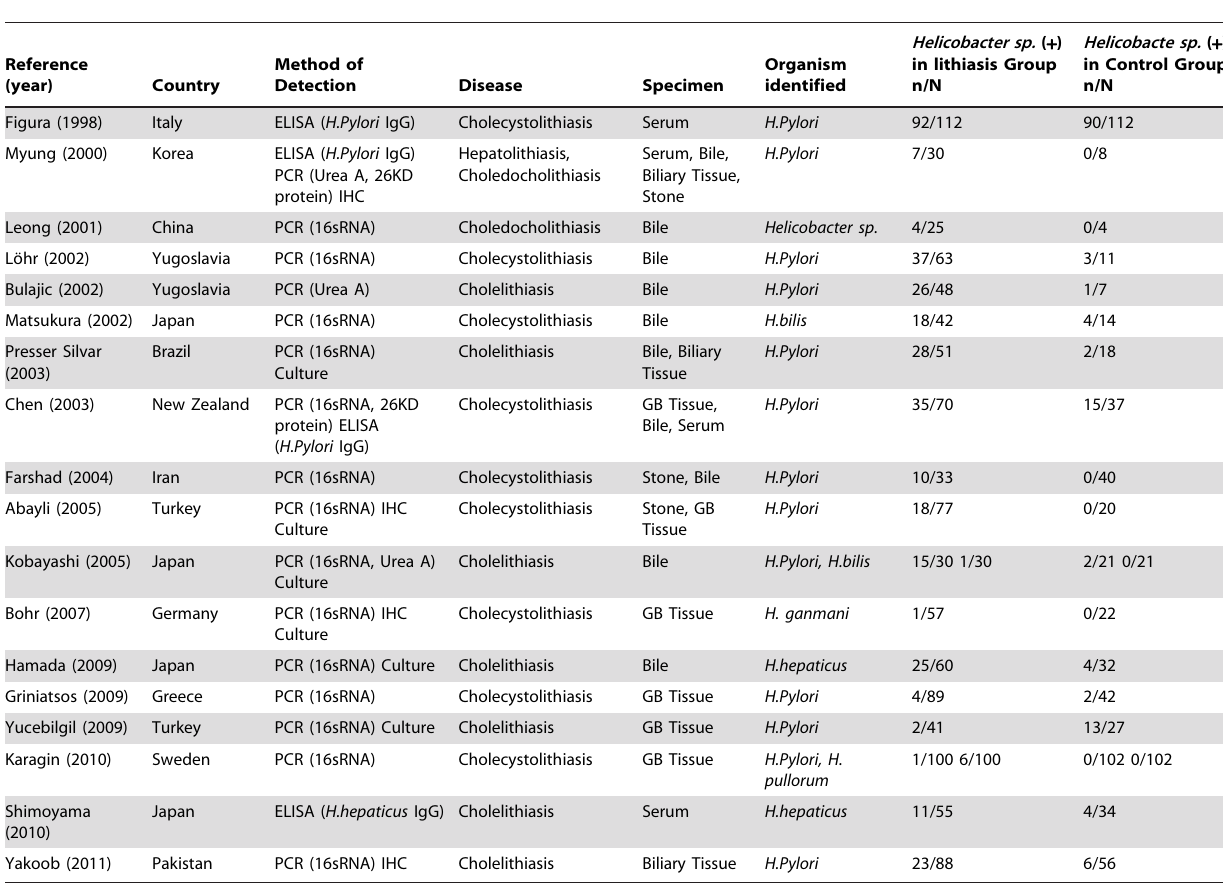
Table 1. Characteristics of studies on Helicobacter sp. in cholelithiasis patients and control group.